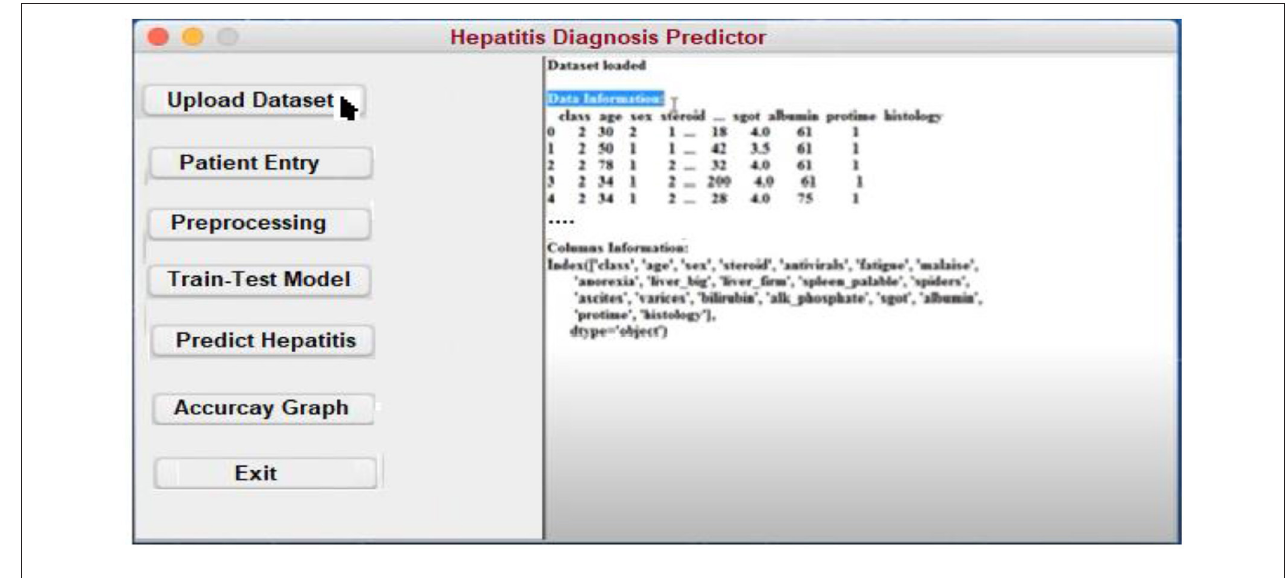
FIGURE 9 | Hepatitis prediction data input form.